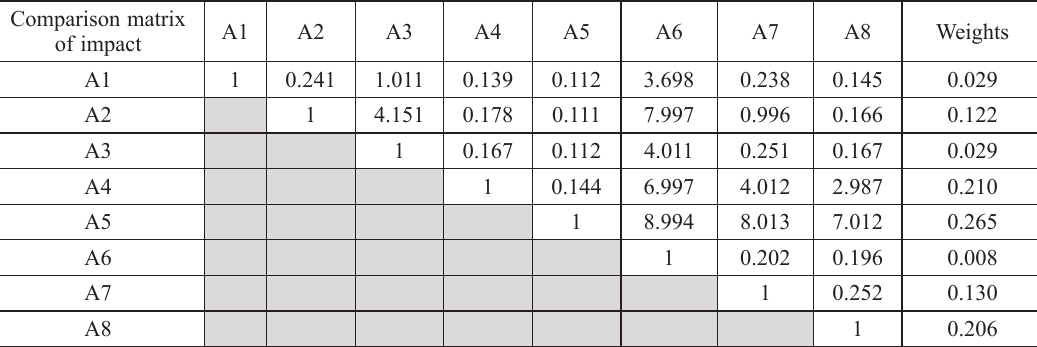
Table 6. Importance degree of any laminated glass models related to maximum impact Comparison matrix of